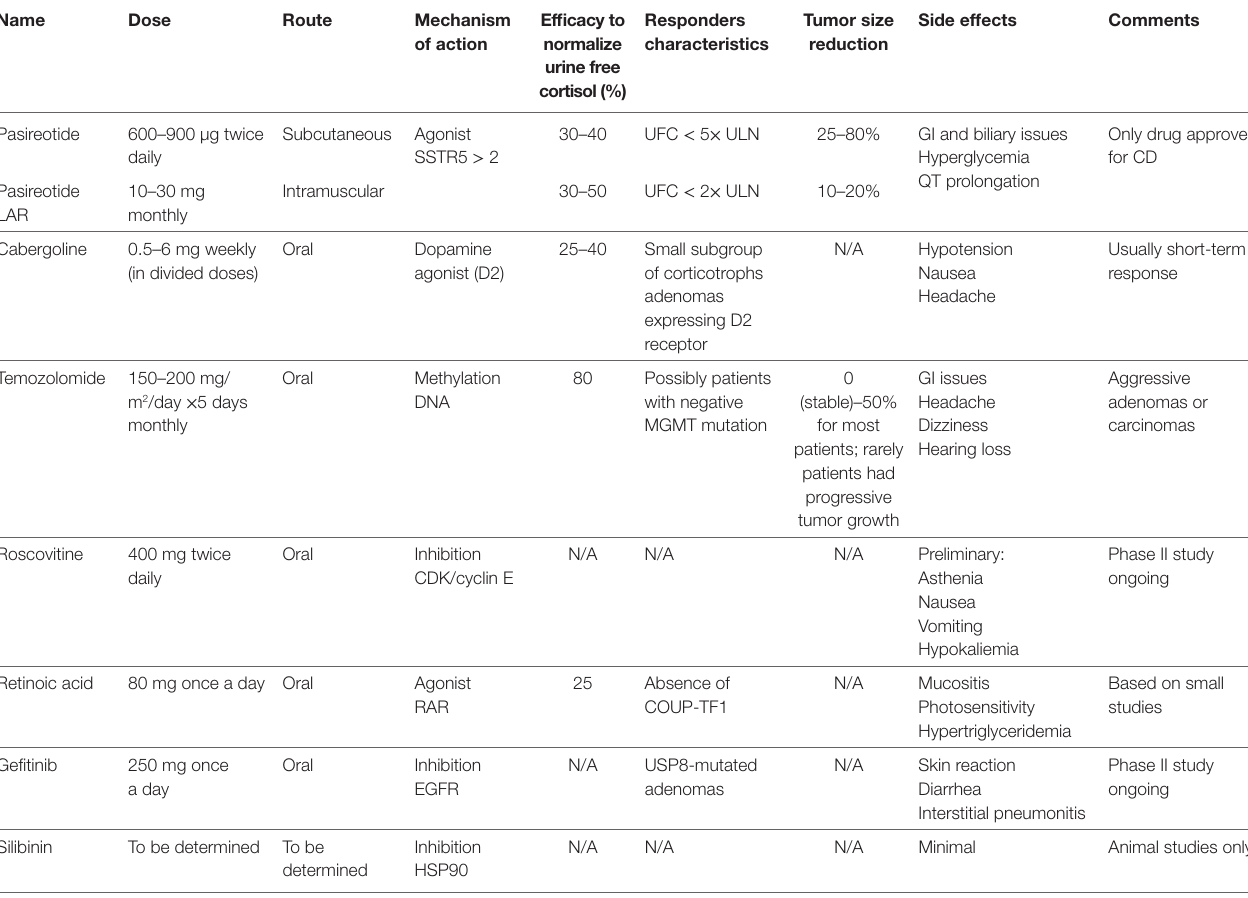
TABLe 2 | Summary of pharmacologic therapies for Cushing’s disease (28, 30, 31, 55, 71,